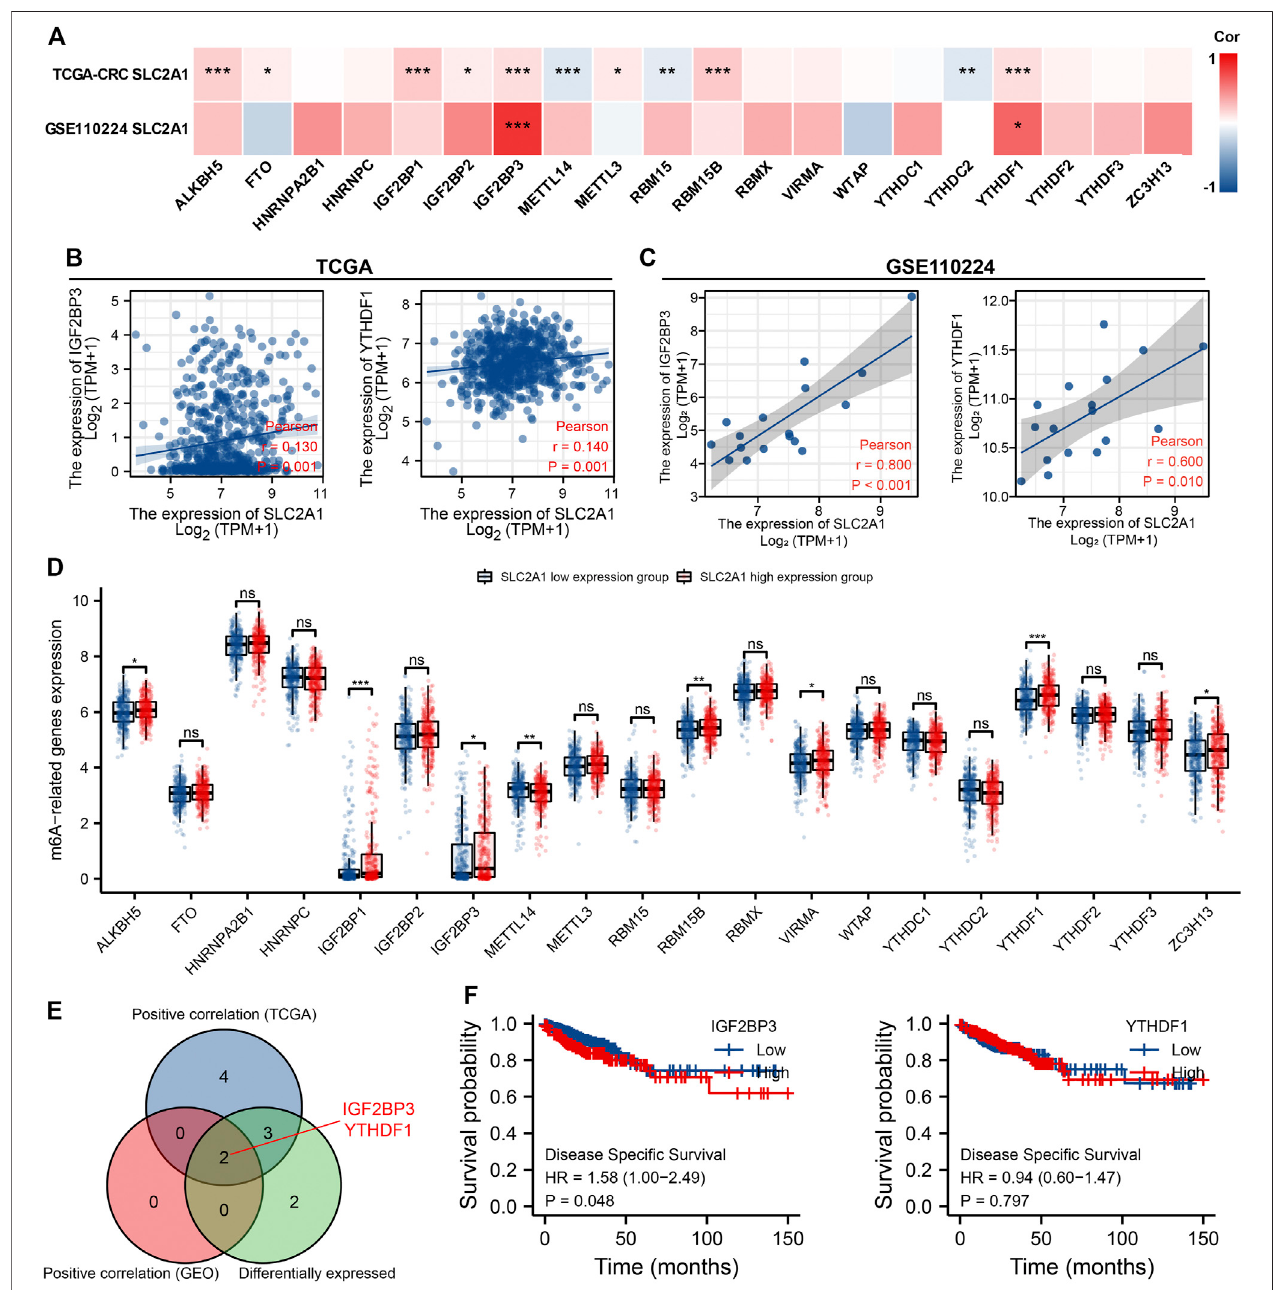
FIGURE 7 | Associations of SLC2A1 expression with m6A relative genes in colorectal cancer (CRC). (A) GSE110224 and TCGA CRC cohort analyzed the association between the SLC2A1 and the 20 m6A relative genes expression in CRC. (B) TCGA CRC cohort was analyzed and a scatter plot was drawn to display the association between SLC2A1 and the expression of m6Arelativegenes, including IGF2BP3 and YTHDF1. (C) GSE110224 cohort wasanalyzed, and ascatter plot was drawn to display the association between SLC2A1 and the expression of m6A relative genes, including IGF2BP3 and YTHDF1. (D) The differential expression of 20 m6A relative genes between high and low SLC2A1 expression groups in CRC tumor samples. (E) Venn diagram indicated both expression association and differential expression of genes, including IGF2BP3 and YTHDF1. (F) The Kaplan – Meier curve of IGF2BP3 and YTHDF1. *, p < 0.05; **, p < 0.01; ***, p < 0.001; ****, p < 0.0001; ns, no signi fi